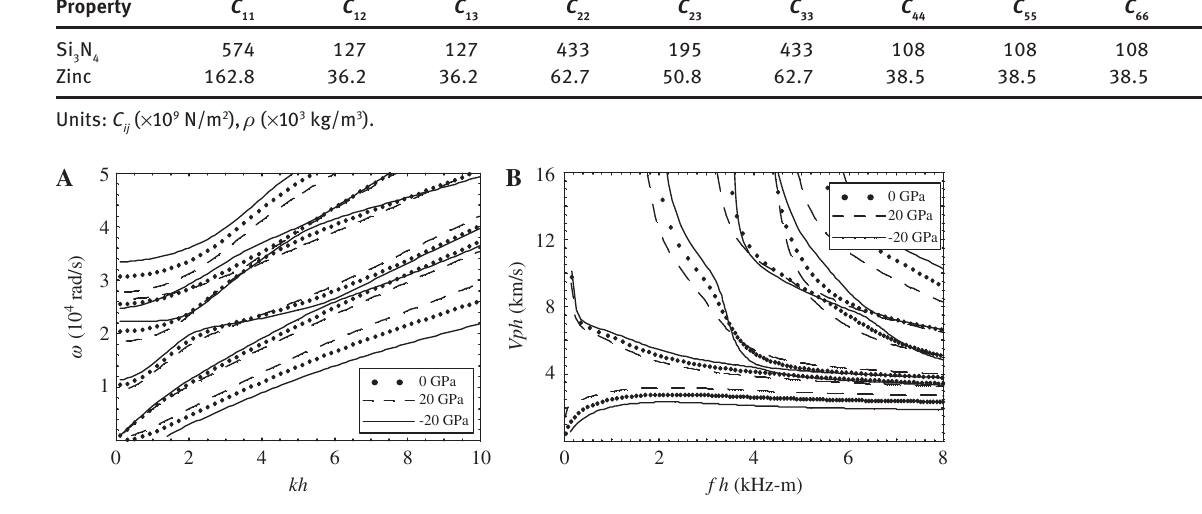
Table 1 The material parameters of the two materials. Property